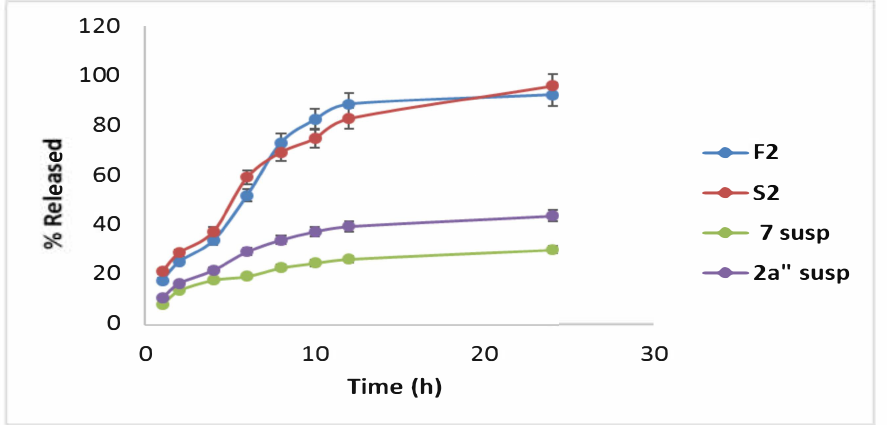
Figure 20. Percentage of either 2a or 7 released ± S.D. from the optimized TPGS-coated niosomal formula (F2 and S2) compared to that of 2a and 7